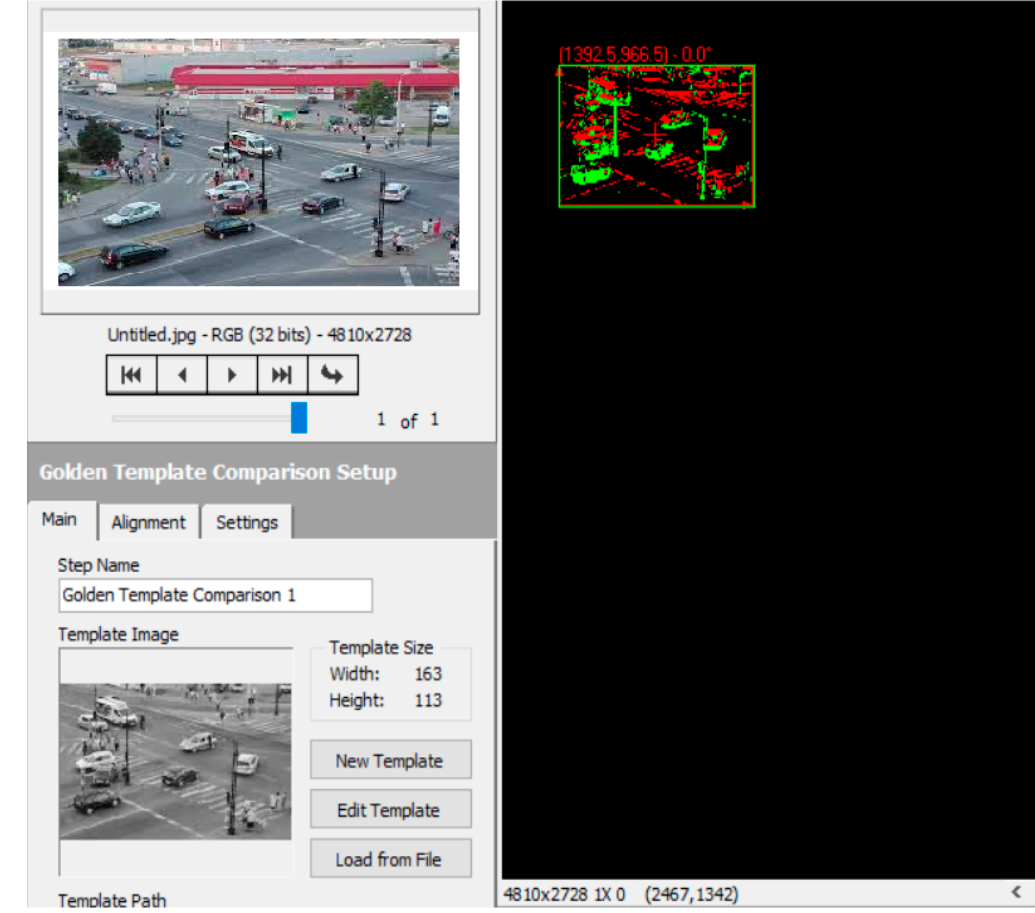
Figure 8. Traffic conflict detection at intersections (frame 5).